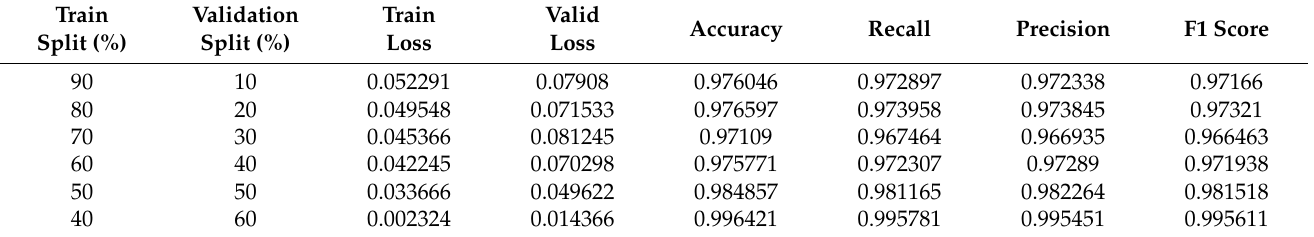
Figure 10. A plot of validation split ratio and layer depth over time.